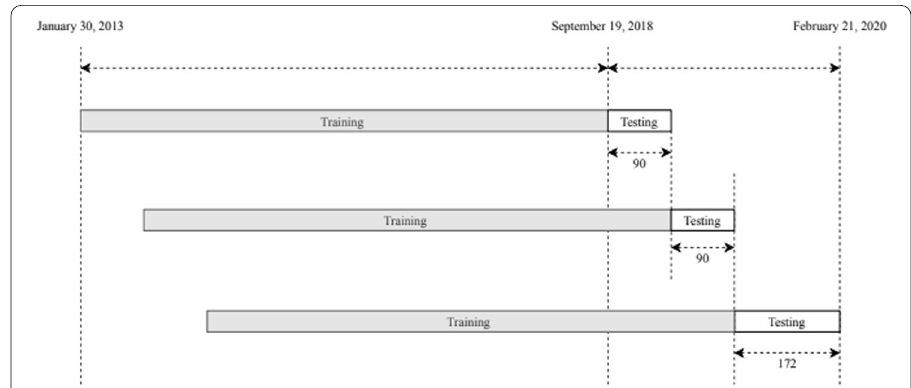
Fig. 5 Rolling forecast